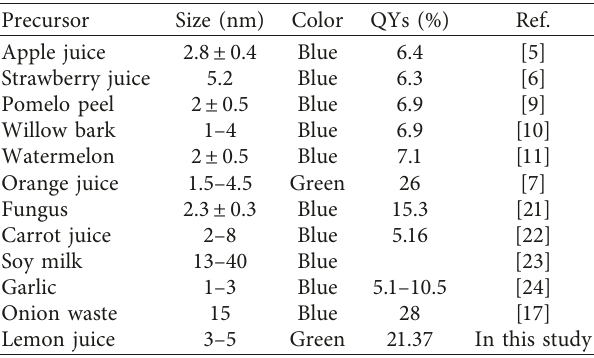
Figure 11: The dependence of luminescent intensity on the absorption of (a) sodium fluorescein and (b) C-dots synthesized at 150 ° C for 12h. Table 1: Comparison of the QYs of C-dots prepared by various natural